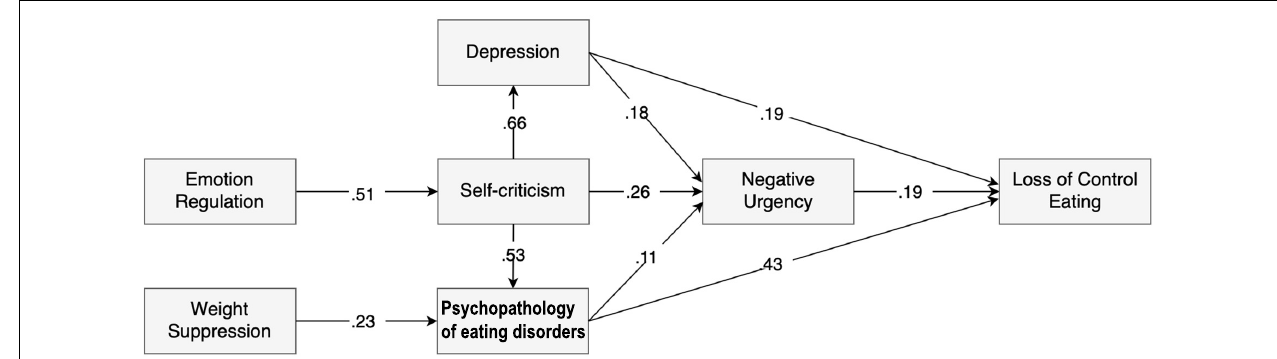
FIGURE 2 | LOC over eating: structural equation model depicting the interplay between disordered eating-related variables and other psychological variables. All paths represented between each variable are significant with p < 0.05. Path 1 – Weight suppression → Psychopathology of eating disorders → Loss of control eating. Path 2 – Emotion regulation → Self-criticism → Depression → Negative urgency → Loss of control eating. Path 3 – Self-criticism → Psychopathology of eating disorders → Negative urgency → Loss of control eating.